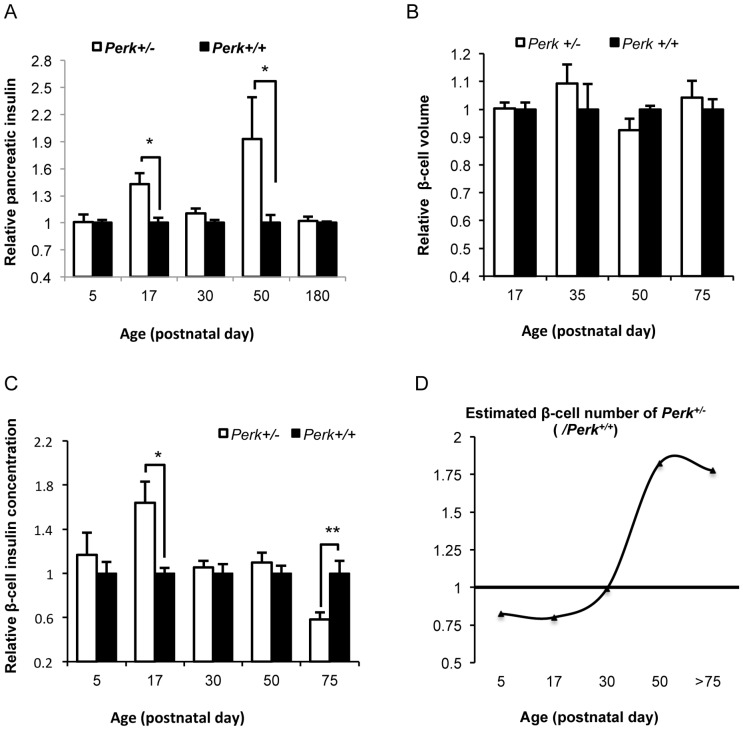
Insulin production was modulated by Perk during development.A. Total pancreatic insulin content of Perk+/− mice relative to Perk+/+ during postnatal development. Shown are means ± SEM (n for Perk +/−, Perk+/+  =  14, 16 (P5); 8,5 (P17); 18, 16 (P30); 10, 15 (P50); 8, 6 (P180). *P<0.05). B. β-cell volume of Perk+/− mice relative to Perk+/+ during postnatal development. Shown are means ± SEM (n for Perk +/−, Perk+/+  =  3, 4 (P17); 4, 4 (P35); 4, 3 (P50); 3, 3(P75). No statistical significance was observed at any developmental time point). C. Estimated β-cell insulin concentration of Perk+/− mice relative to Perk+/+ during postnatal development. Age of mice was shown as indicated, except that mice belonging to P75 group had ages ranging from P70 to P90. Shown are means ± SEM (n for Perk +/−, Perk+/+  =  7,6 (P5); 9, 11 (P17); 6, 9 (P30); 11, 16 (P50); 9, 8(P75). *P<0.05, **P<0.01). D. Estimated β-cell number of Perk+/− mice relative to Perk+/+ using insulin content in the whole pancreas divided by estimated insulin content per cell.